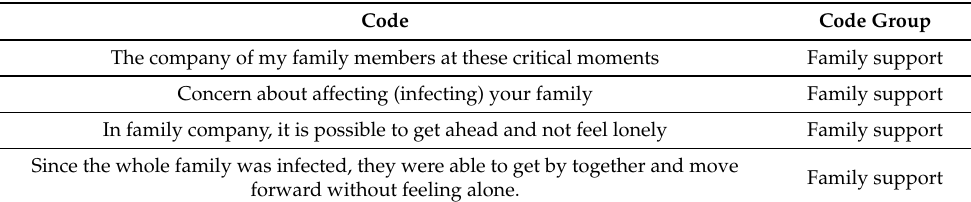
Table 7. Code group: family